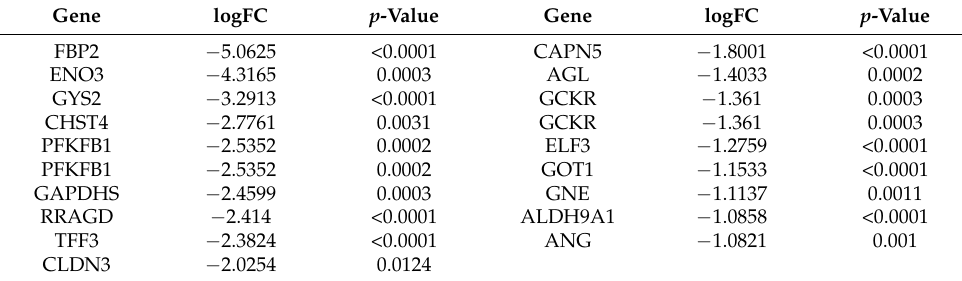
Table 2. The downregulated glycolysis-related genes in OSCC.